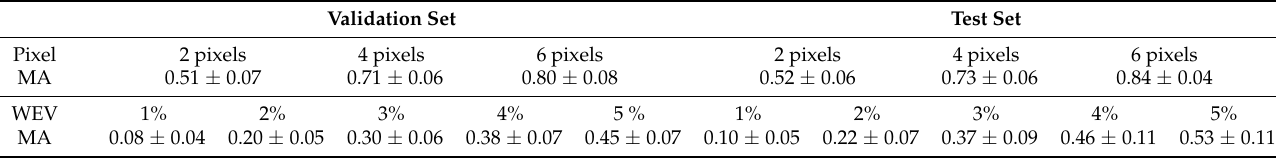
Table 3. Mean difference, mean absolute error, and ICC in the validation and test sets.